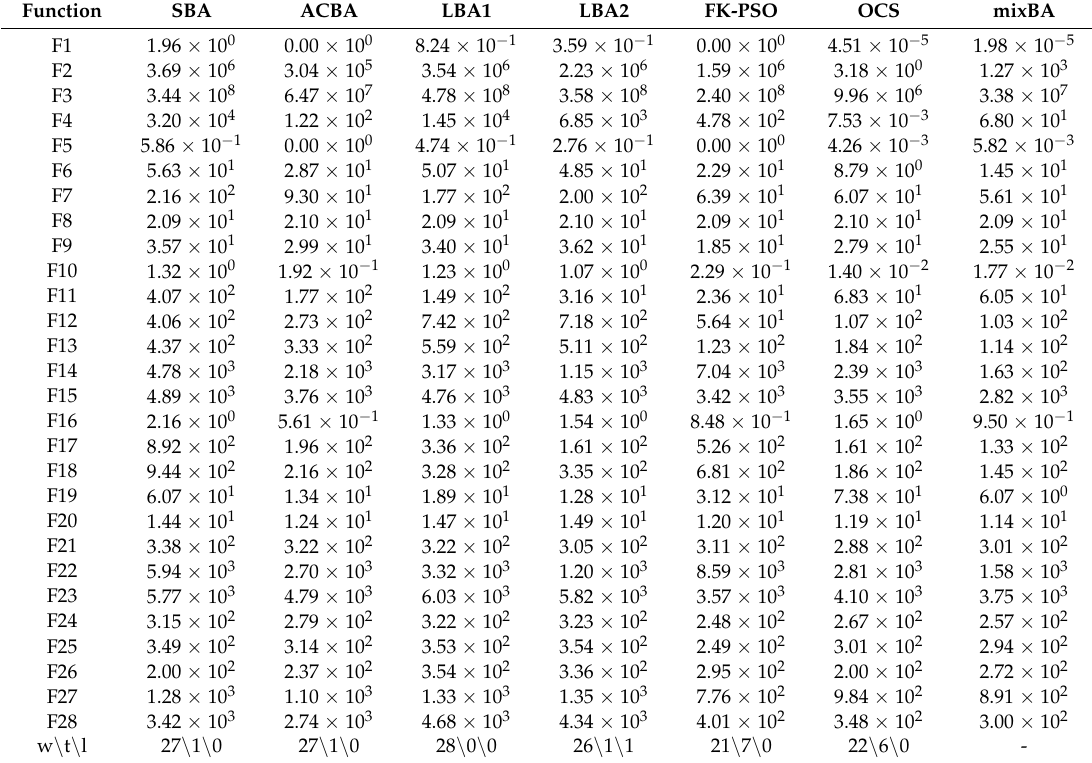
Table A1. Comparison results for mixBA and the other six algorithms.